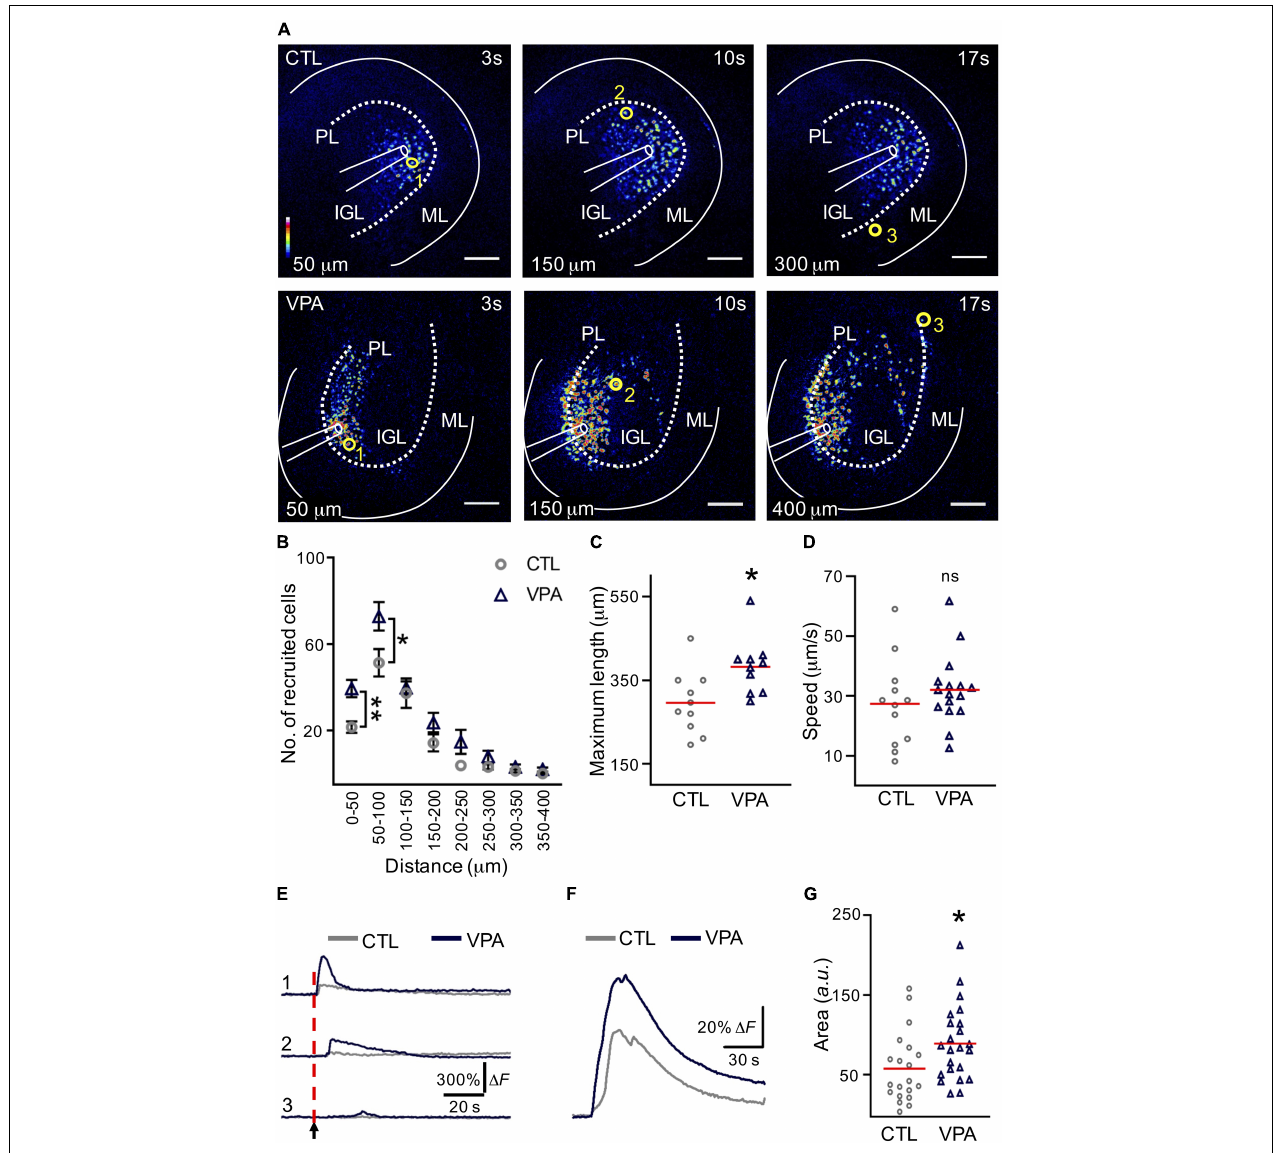
FIGURE 2 | The calcium wave is augmented in the VPA model. (A) Evoked calcium waves in control (CTL) and VPA groups. Pseudocolors (from blue to white) represent the intensity of the fluorescent calcium indicator (Fluo4-AM). Scale bar 100 µ m. (B) Graph of the recruited cells per distance (n CTL = 10, N CTL = 7, n VPA = 10, N VPA = 9). (C) Maximum length of the calcium wave (n CTL = 10, N CTL = 7, n VPA = 10, N VPA = 9). (D) Calcium-wave speed (n CTL = 12, N CTL = 8, n VPA = 16, N VPA = 12). (E) Examples of the activation of three cells recruited at different distances in the evoked calcium wave [yellow circles in (A) : cell 1, 50 µ m; cell 2, 150 µ m; cell 3, 300 or 400 µ m]. (F) The mean amplitude of the calcium transients was estimated from all the recruited cells within the calcium wave in both CTL (Cells CTL = 1222, n CTL = 20, N CTL = 13) and VPA (Cells VPA = 967, n VPA = 23, N VPA = 15) experimental groups. (G) Summary of the mean of amplitudes of the calcium transients obtained from all the recruited cells from CTL and VPA groups. IGL, internal granular layer; PL, Purkinje layer; WM, white matter. Data analyzed